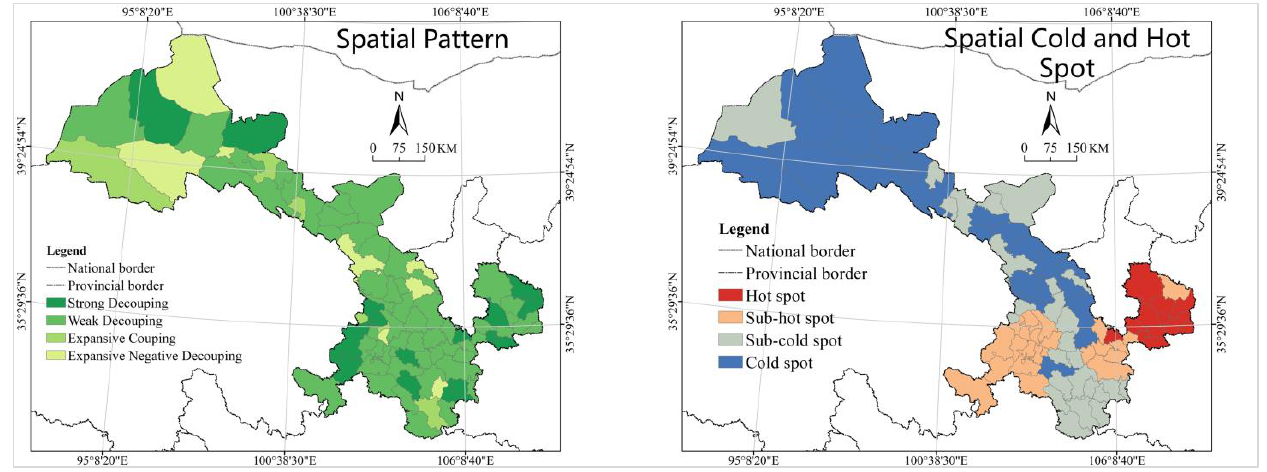
Figure 14. Spatial analysis on the decoupling relationship between urban construction land and res- ident income in